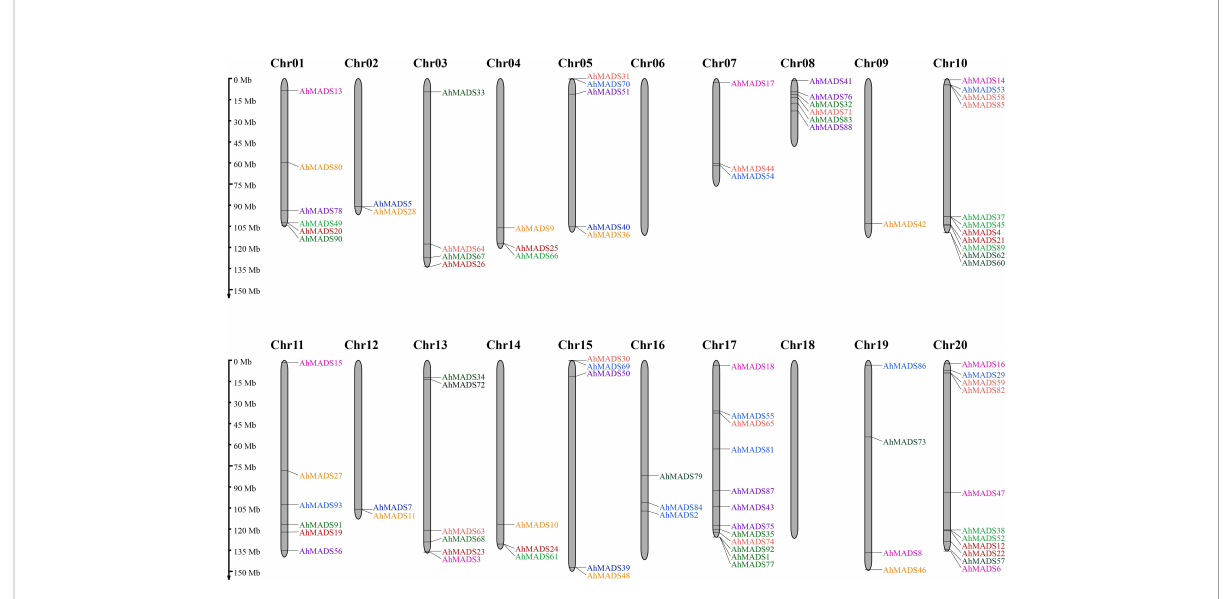
FIGURE 4 Chromosomal location of MIKC-type MADS-box proteins. In total, 93 AhMADS genes were located on 18 chromosomes. Genes from different subfamilies are shown in different